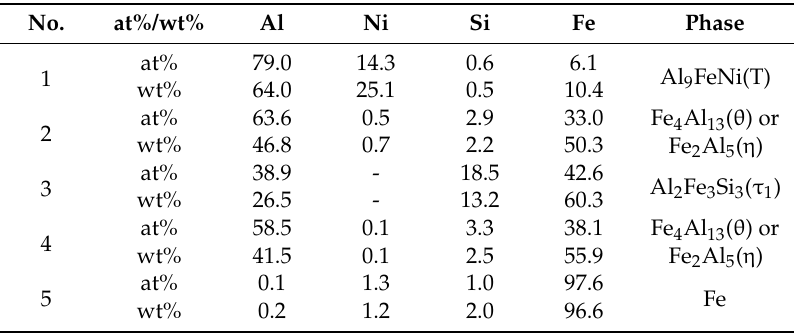
Table 3. EDS analysis results of phases denoted as 1–5 in Figure 5.